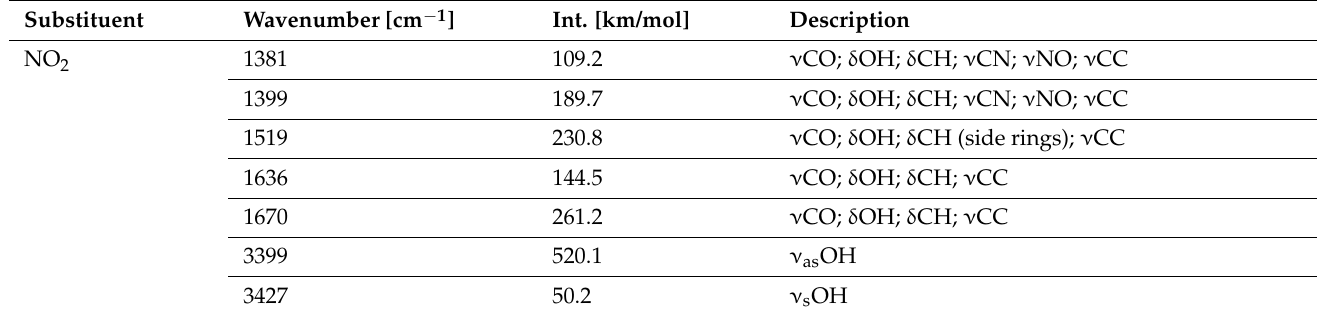
Table 3. Selected bands without a scaling factor for the optimized dihydroanthrones. Only the fa- vored keto form (K6) with different substituents has been included .